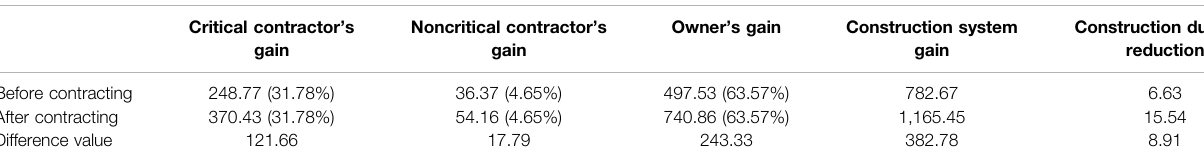
TABLE 7 | Comparisons of gain functions and construction durations in Scenario I.